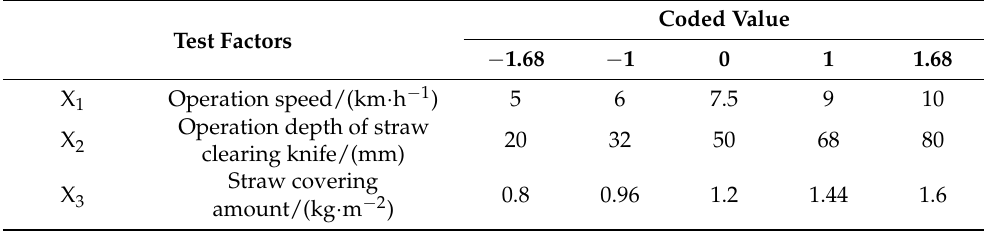
Table 3. Test-factor level coding table. Test